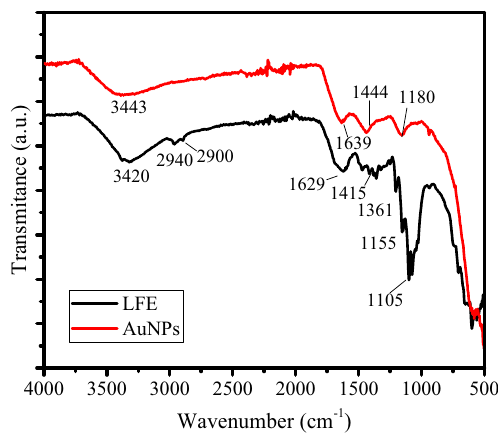
Figure 2: Comparison of FTIR spectra of LFE and AuNPs.